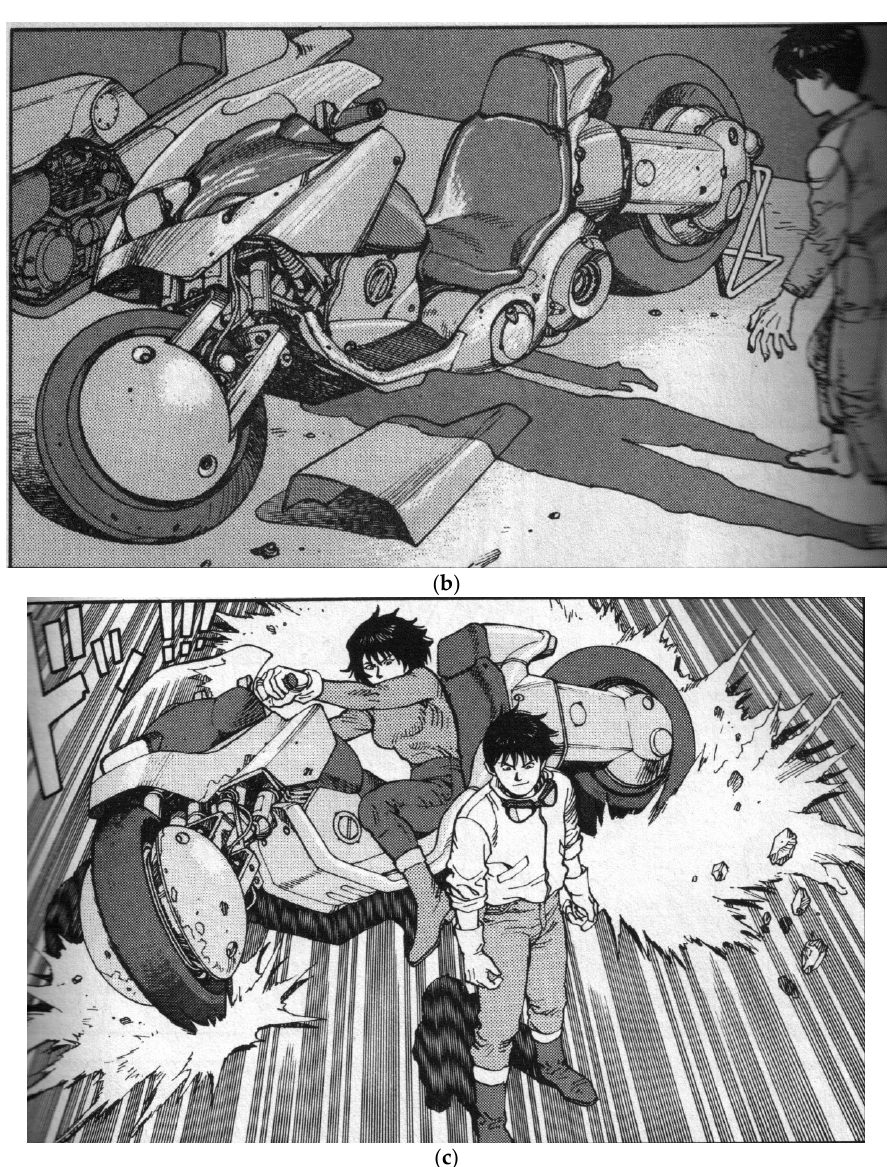
Figure 2. ( a ) panel from Katsuhiro Ō tomo, Akira (K ō dansha), vol. 1 (1984), p. 16; ( b ) vol. 5 (1990), p. 55; ( c ) vol. 6 (1993), p. 420.